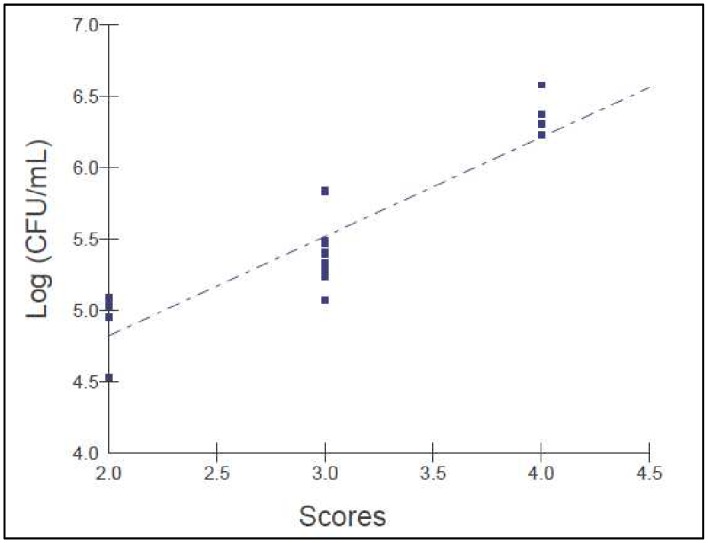
Correlation between the scores assigned to oral lesions with the CFU number/mL within the 5 to 16-day period post-infection in the murine model of oral candidiasis (Rs = 0.92; p≤0.0001).